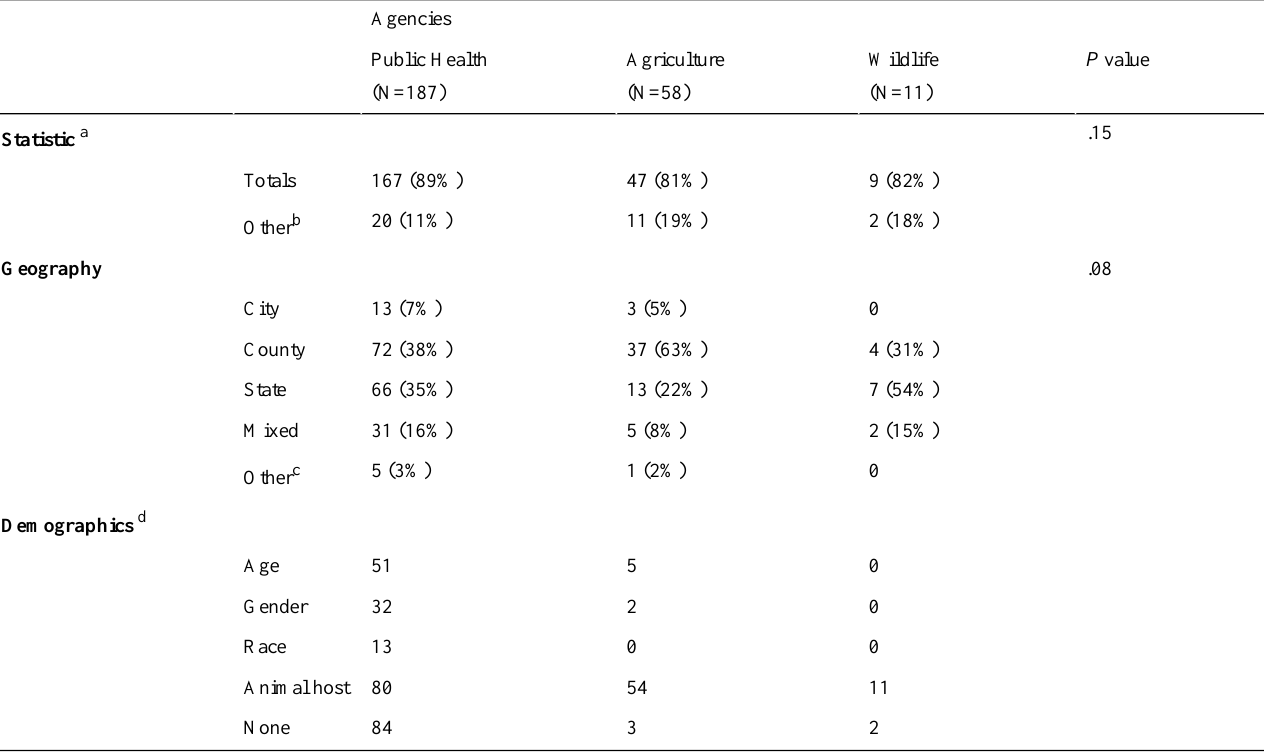
Table 1. Comparison by agency type of the number of states that provided zoonotic viruses data on websites by type of statistic used, level of geography, and inclusion of demographics, 2000-2012 (data combined for each of virus in Figure 1; P values determined by chi-square for Statistic and Fisher’s Exact test for Geography; percentages may not add to 100% due to rounding).